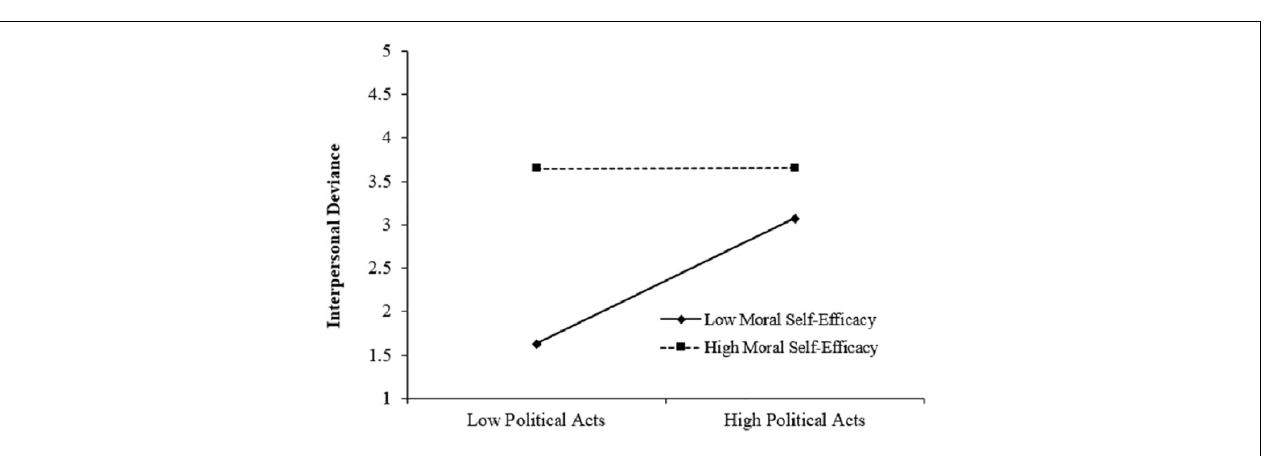
FIGURE 2 | Moderating effect of Chronic Job Strain.